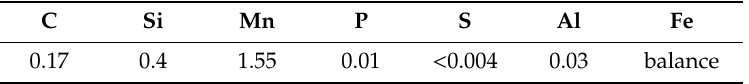
Table 1. Composition of the investigated steel grade (wt.%).